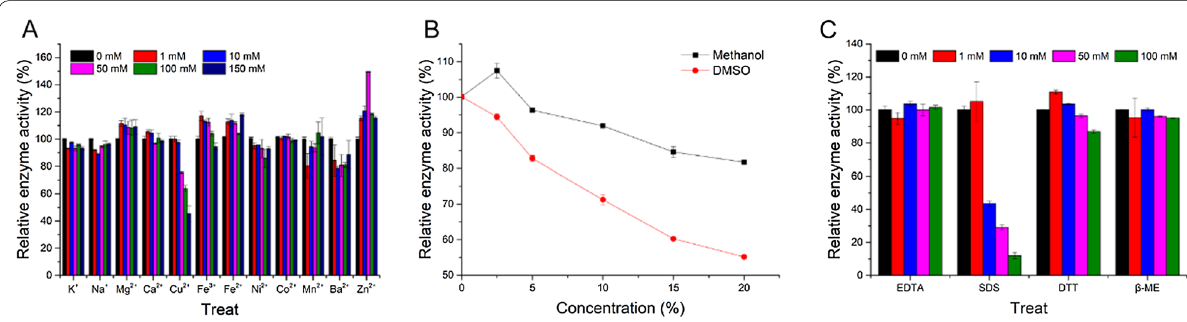
Fig. 3 Effects of metal ions ( A ), organic solvents B and other effectors C on recombinant α-L-rhamnosidase